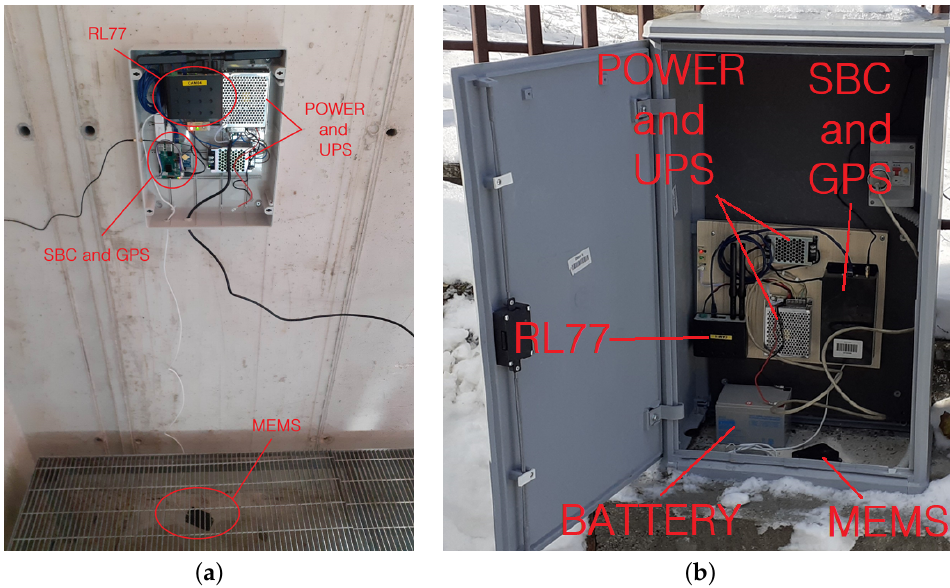
Figure 10. ( a ) Indoor installation with no local connection and an unstable power grid and ( b ) outdoor installation in a cabin on the